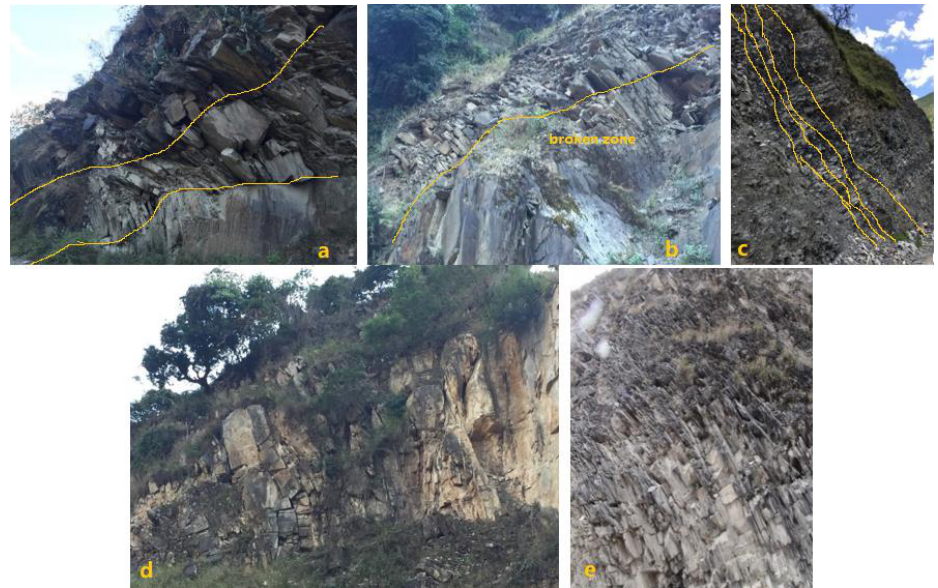
Figure 5. ( a ) The angle of the toppling fracture surface is less than 10° in the reverse slope. ( b ) The change trend of the dip angle of the rock layer. ( c ) The dip angle of the toppling broken failure surface is 63° above the altitude of 1430 m. ( d ) The toppling – loose rock mass of the old highway slope on the downstream side of the Wanba River. ( e ) The toppling – relaxation rock mass of QD5-1 in the transversal.